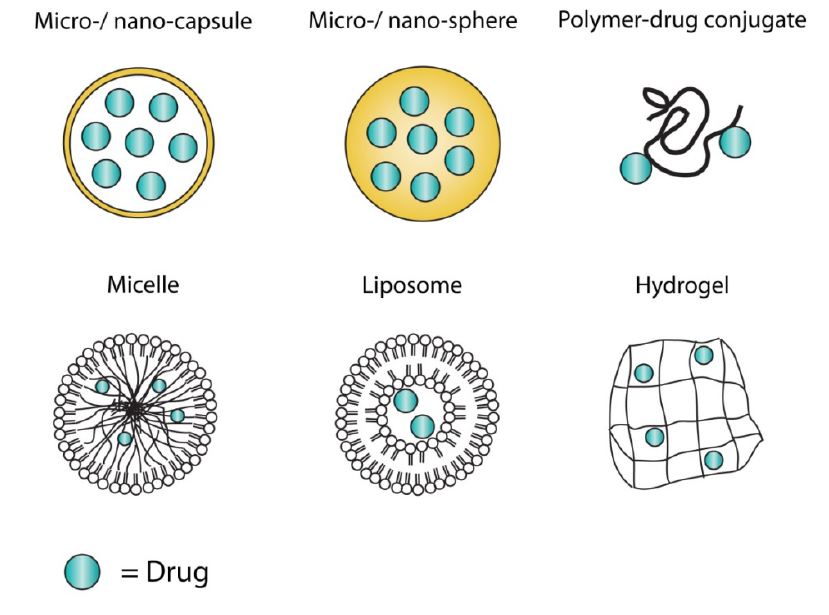
Figure 2. Different structures and morphology of DDSs (not-exhaustive). Each structure has its advantages and disadvantages to incorporate and release different types of drugs for intra-articular treatment of